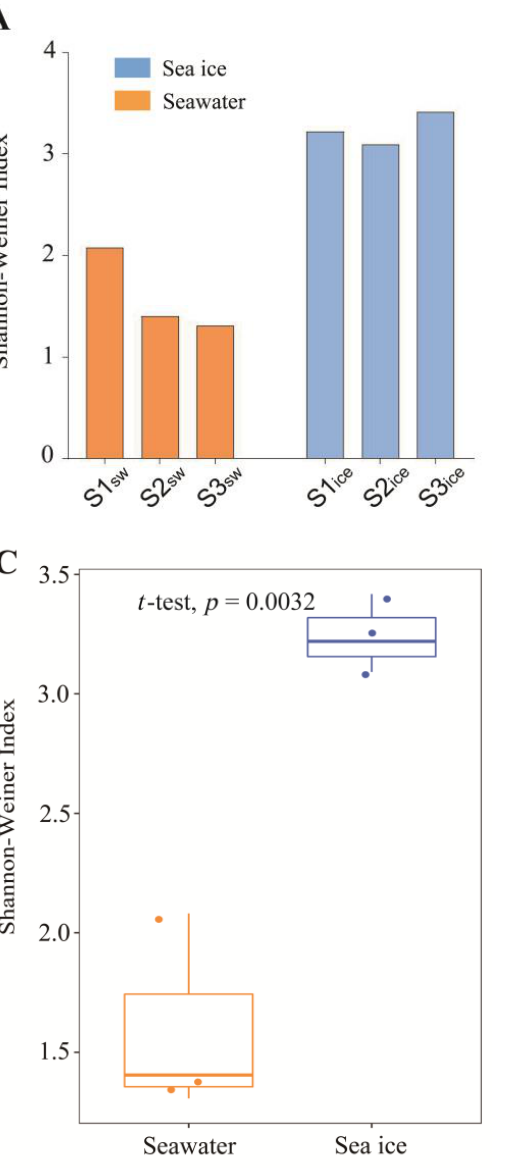
Figure 2. α -diversity of the eukaryotic microalgal community in the seawater and in the sea ice: Shannon’s index ( A ) and evenness ( B ); significance test of Shannon’s index ( C ) and evenness ( D ). A total of six eukaryotic microalgal clades were identified, and the eukaryotic mi- croalgal community in the sea ice and in the seawater was similar in composition at the phylum level (Figure 3A); only Diatomea was more dominant in the seawater samples than in the sea ice samples ( p < 0.05), with a relative abundance accounting for 66–82% of the entire eukaryotic microalgal community in the seawater samples, while it only accounted for 33–42% in the sea ice samples, although the relative abundance was still high. The relative abundances of Dinoflagellata and Chlorophyta were higher in the sea ice samples, accounting for 14–24% and 26–43%, respectively, while the relative abundances in the seawater samples were lower, accounting for 4–14% and 11–18%, respectively. In addition, Prymnesiophyceae, Ochrophyta, and Cryptophyceae were also detected in the seawater and sea ice samples, and were more dominant in the sea ice samples, but their